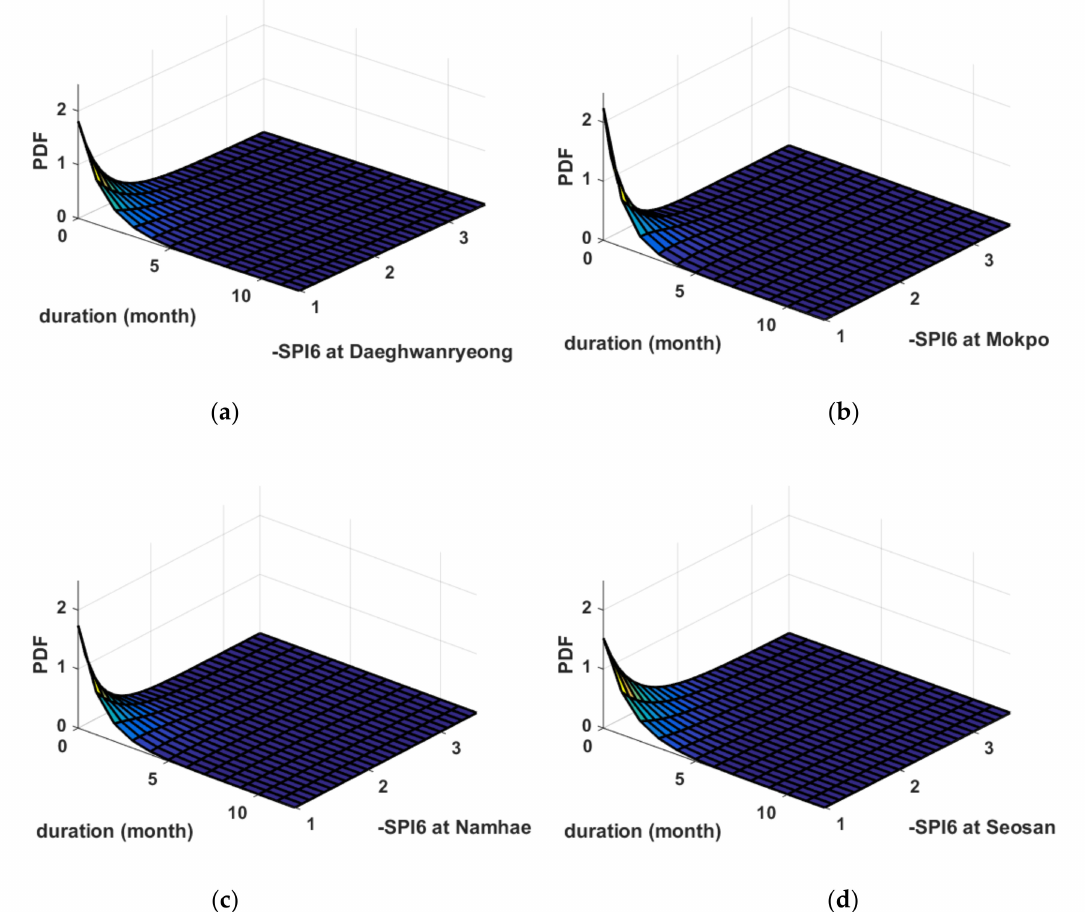
Figure 5. Joint probability density function of drought severity and duration at ( a ) Daeghwanryeong, ( b ) Mokpo, ( c ) Namhae, and ( d )